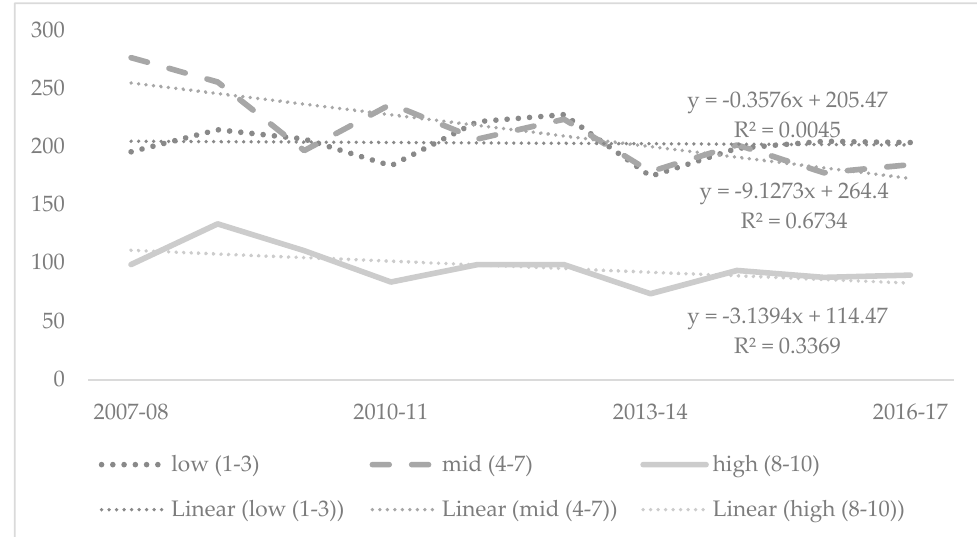
Figure 3. Injury-related fatalities among children and adolescents 0–19 years by index of relative socio-economic advantage and disadvantage (IRSAD) decile, Australia 2007-08 to 2016-17. Note: there were four cases with unknown IRSAD.